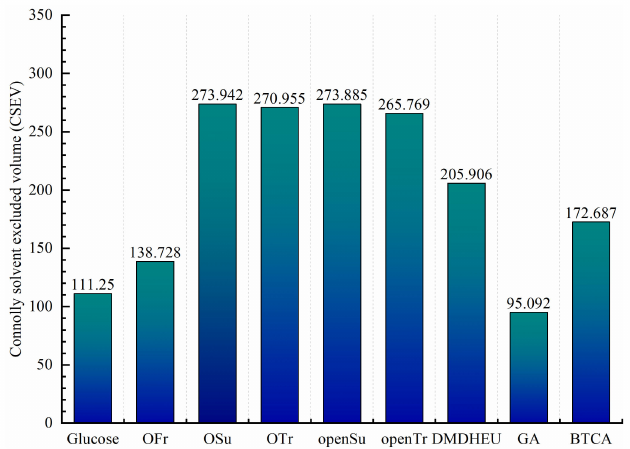
Figure 5. CSEV of different anti-wrinkle finishing